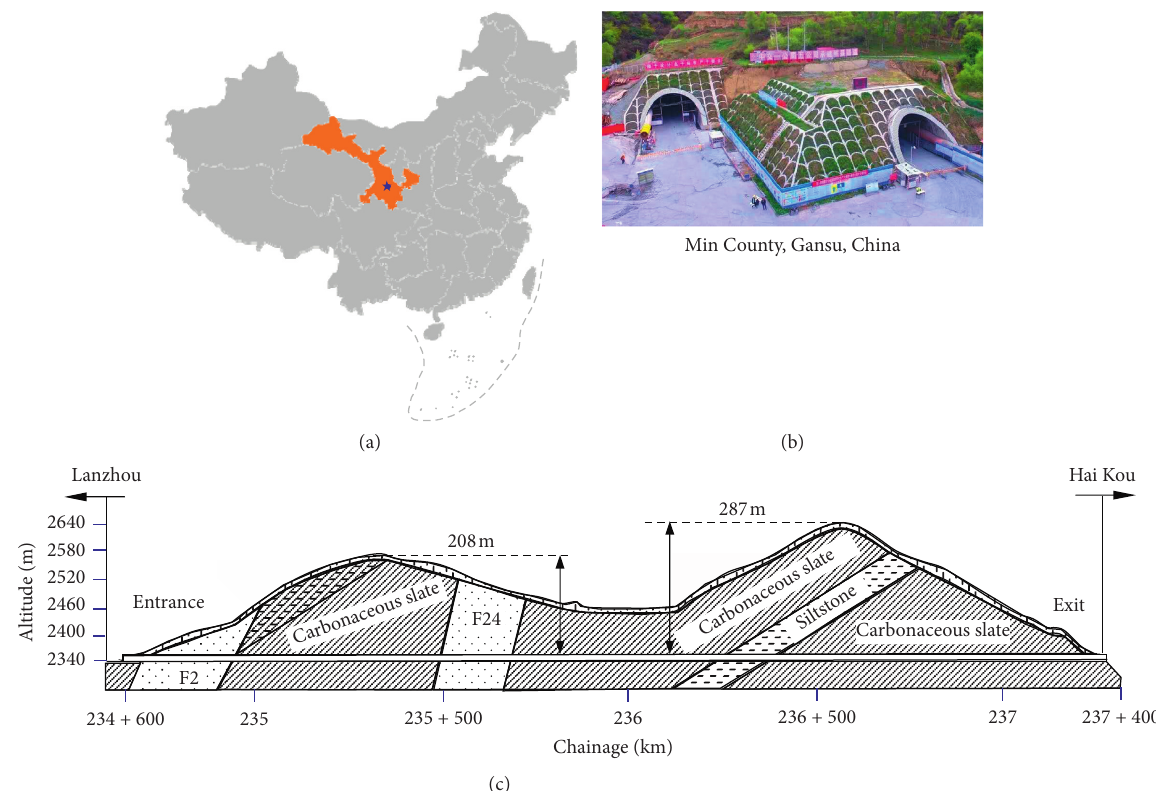
Figure 1: Profile of the Minxian